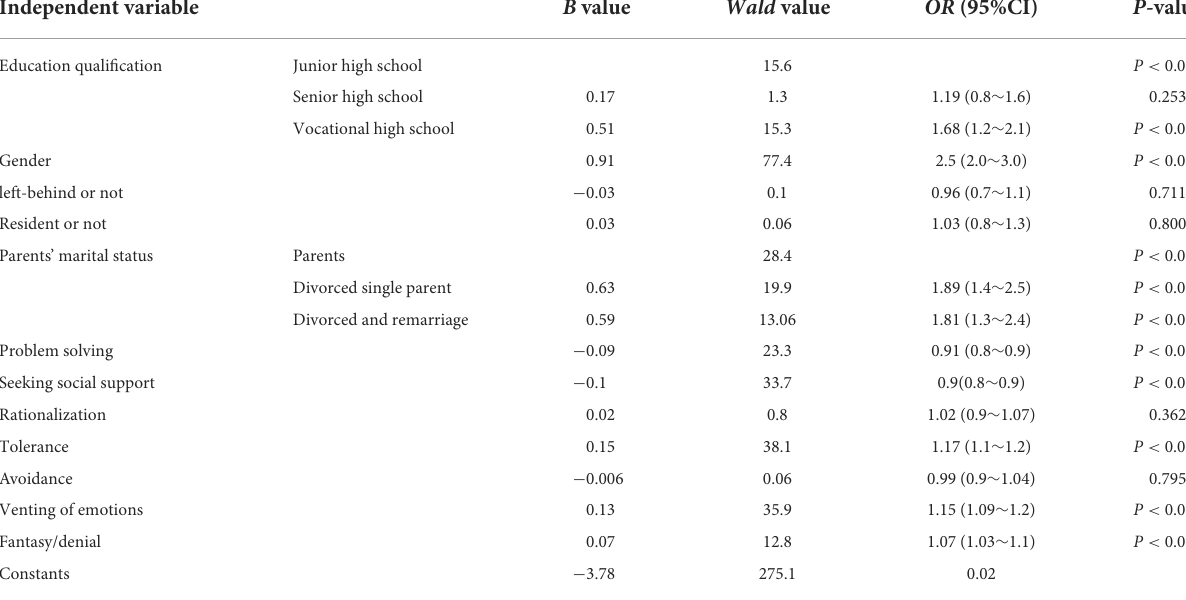
TABLE 3 Multivariate logistic regression analysis of middle school students’ NSSI behavior ( N = 8,361). Independent variable